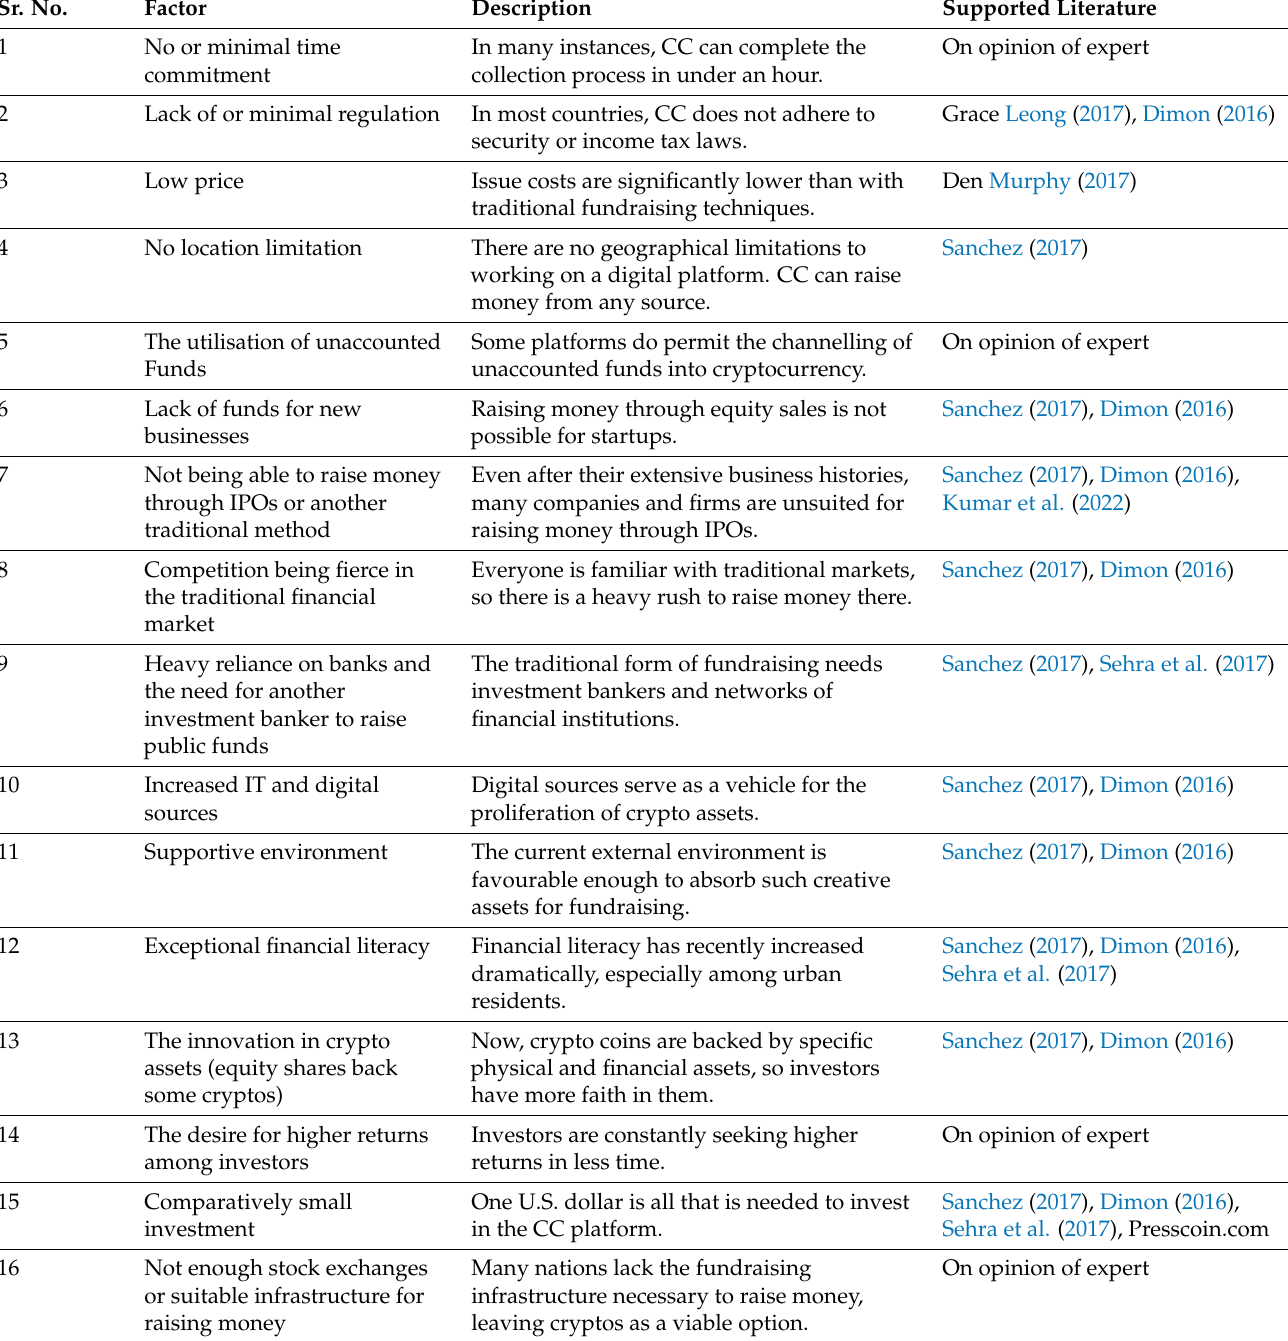
Table 1. Description of CC